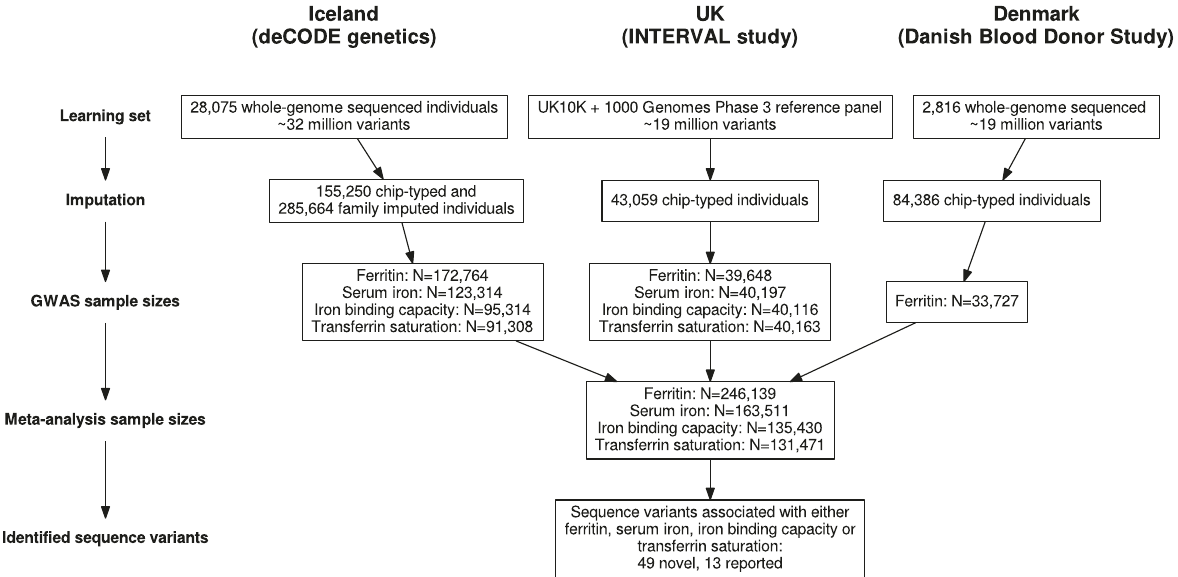
Fig. 1 Study design for meta-GWAS of iron homeostasis biomarkers. A fl owchart describing the study design of the iron homeostasis biomarker GWAS meta-analysis of Icelandic, UK, and Danish